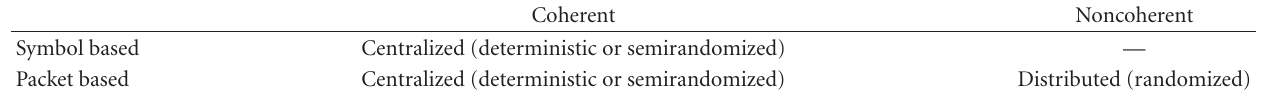
Table 1: Construction possibility depending on network model and the